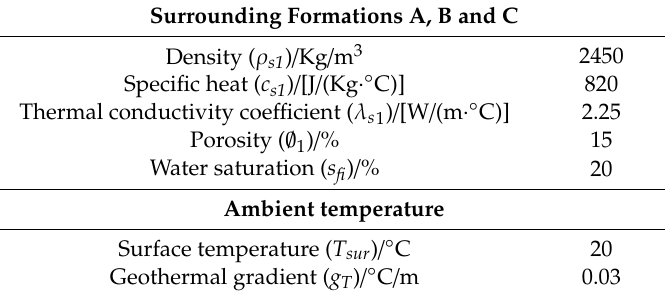
Table 5. Reservoir